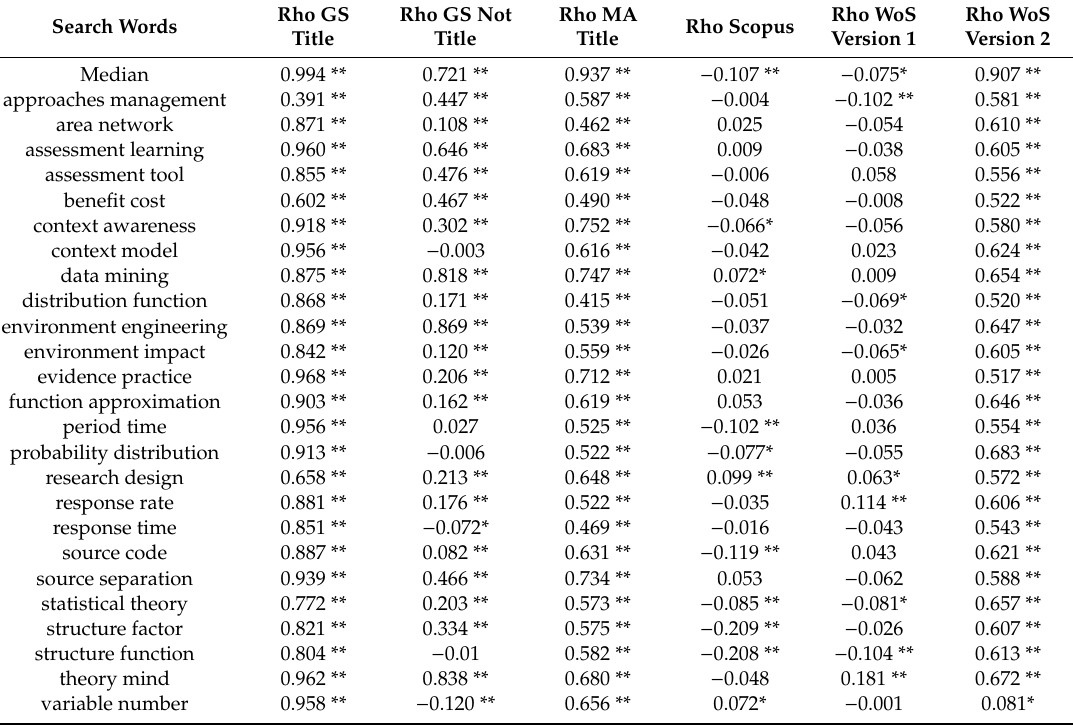
Table A2. Words and Rho of two-term searches. ** p < 0.01, * p <